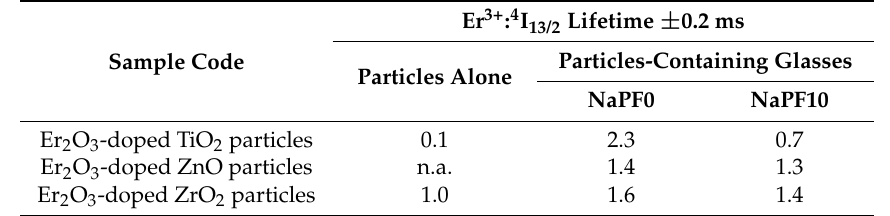
Table 1. Er 3+ : 4 I 13/2 lifetime values of the Er 2 O 3 -doped TiO 2 , ZnO and ZrO 2 particles and of the particles-containing NaPF0 and NaPF10 glasses.